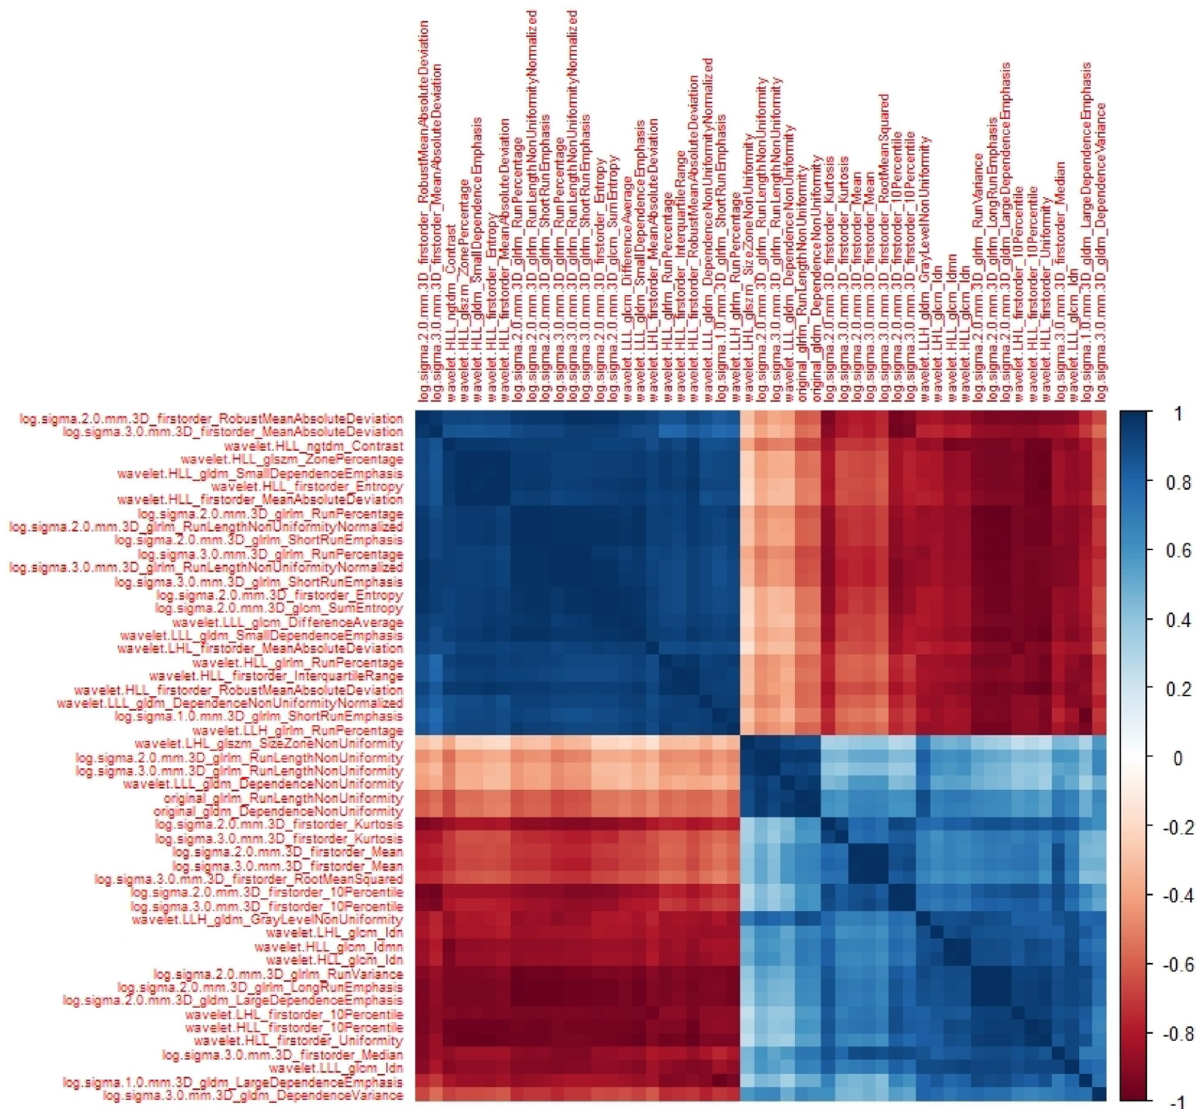
Figure 4. Heatmap showing Spearman correlations between the top 50 repeatable